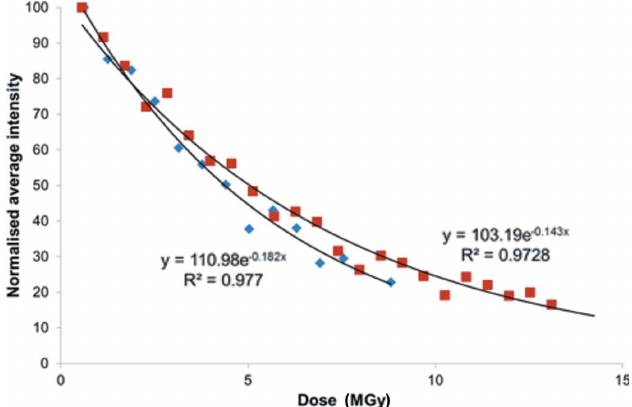
Figure 7 Average integrated intensity (normalized to 100) for each scan for experiment 1 (diamonds) and experiment 4